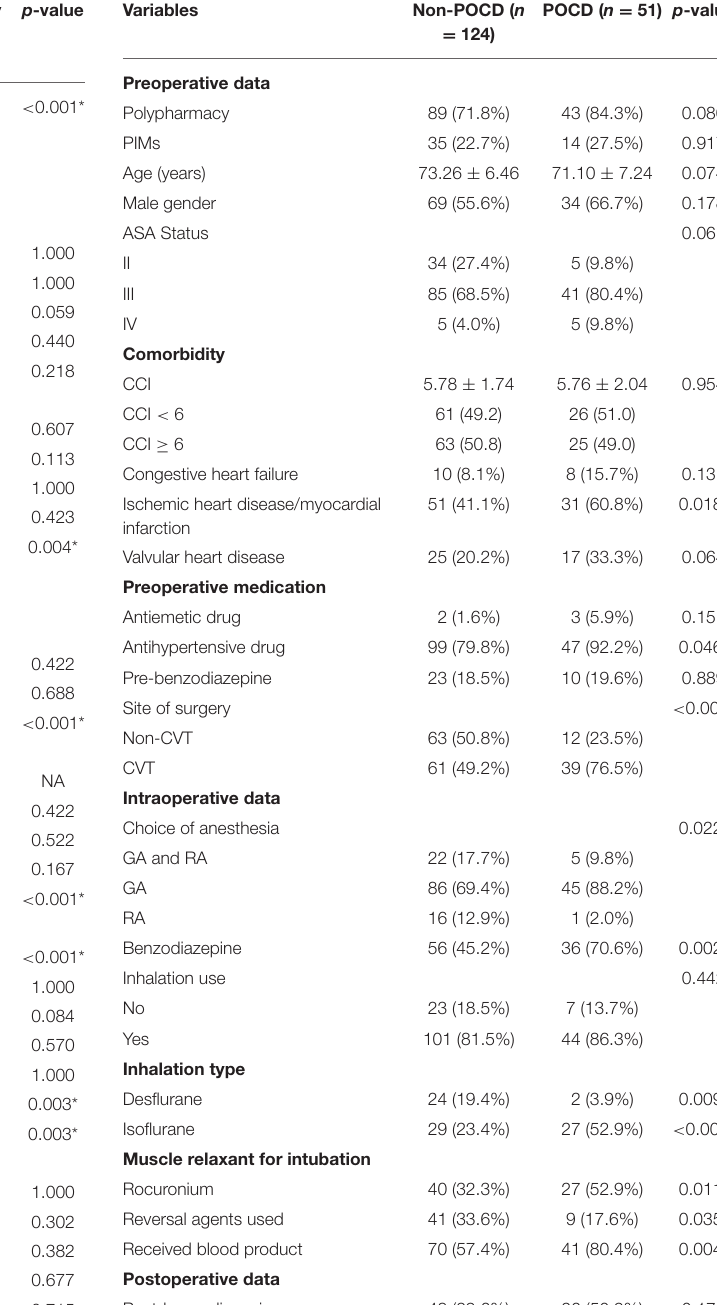
TABLE 3 | Intraoperative data compared between the non-polypharmacy and polypharmacy groups.